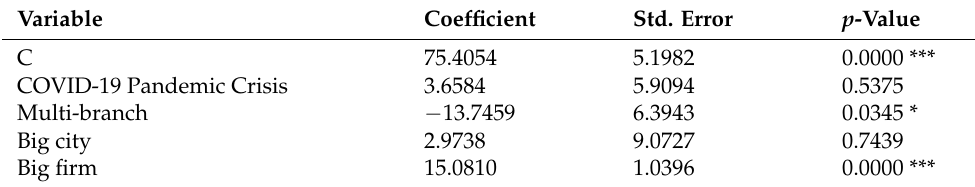
Table 4. The results of the third research model.